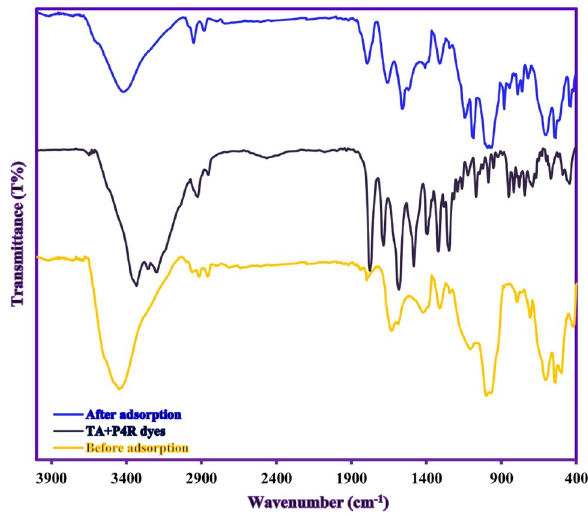
Figure 11. FTIR spectra of ZnS/CuO-CNT (before and after adsorption of TA + P4R dyes).